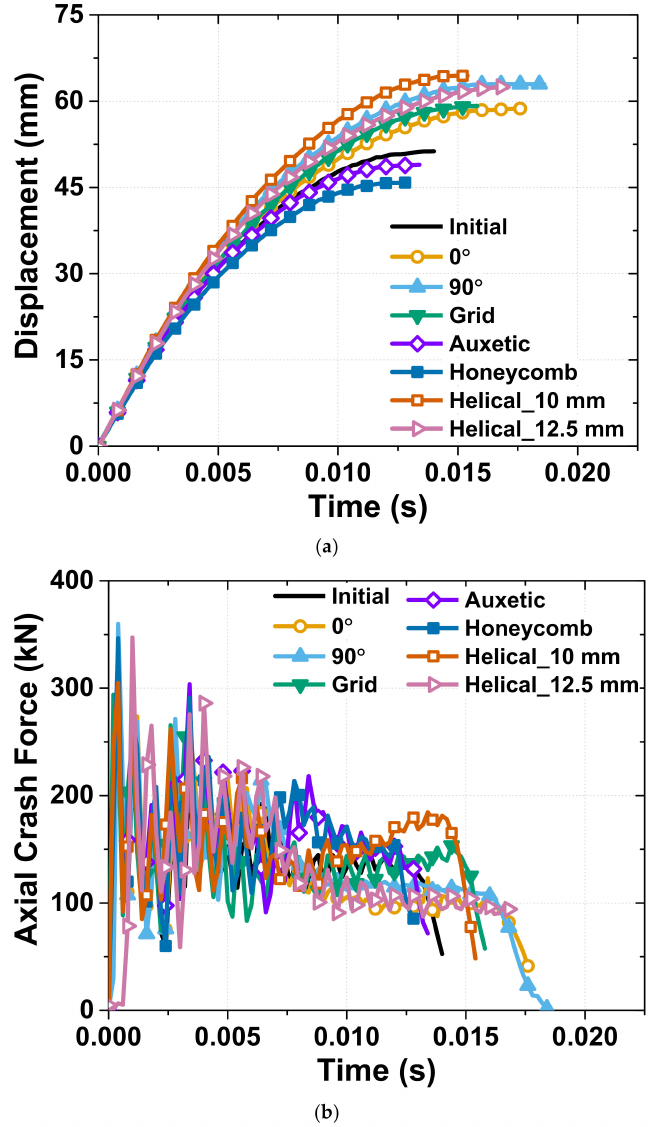
Figure 5. Experimental results of dynamic crash test: ( a ) displacement; ( b ) axial crash force according to